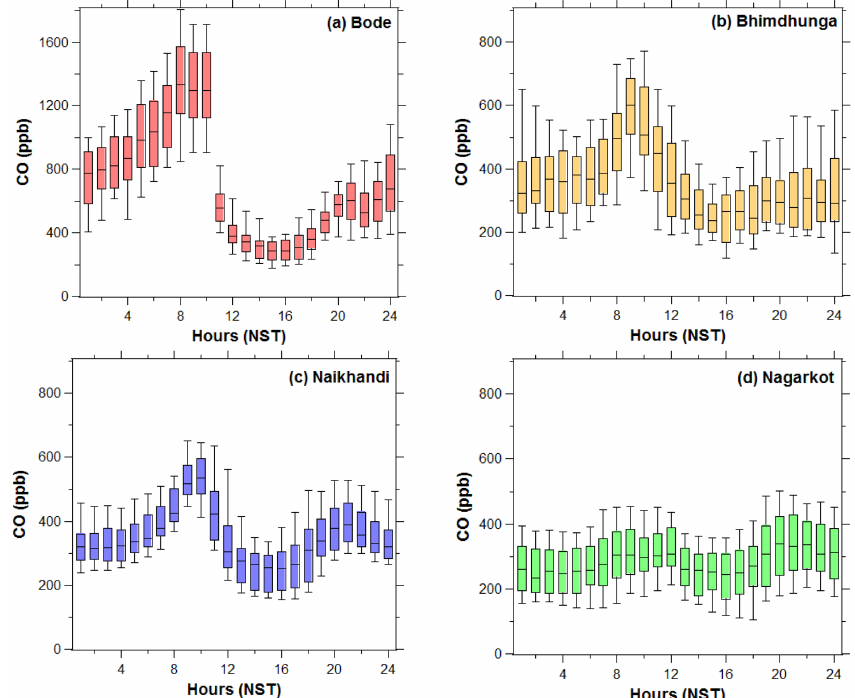
Figure 3. Diurnal variations of hourly average CO mixing ratios during the common observation period (13 February–3 April 2013) at Bode, Bhimdhunga, Naikhandi and Nagarkot. The lower end and upper end of the whiskers represent the 10th and 90th percentile, respectively; the lower end and upper end of each box represent the 25th and 75th percentile, respectively, and the black horizontal line in the middle of each box is the median for each month. Note: the y -axis scale of Bode is twice that of the other three